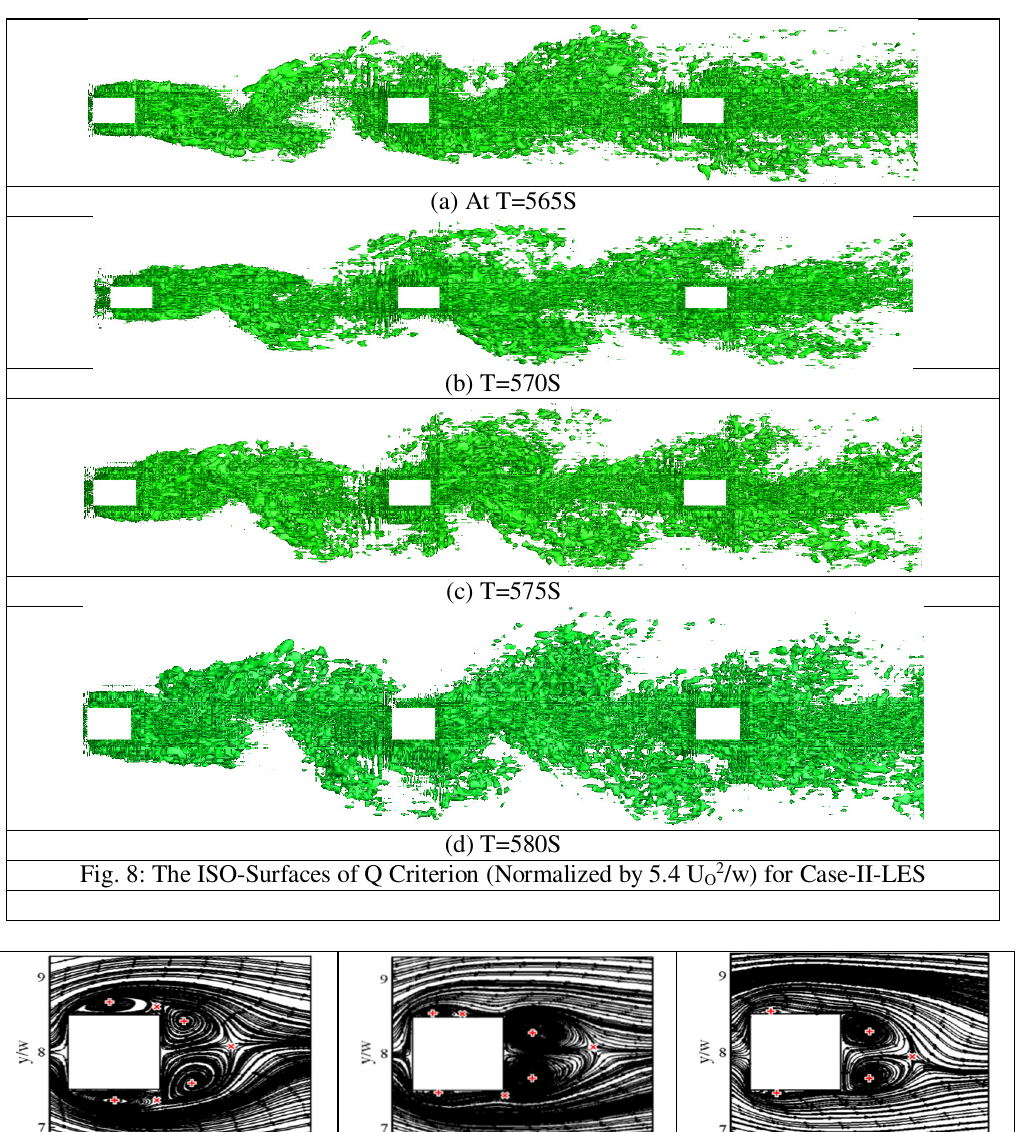
Fig. 8: The ISO-Surfaces of Q Criterion (Normalized by 5.4 U O2 /w) for Case-II-LES